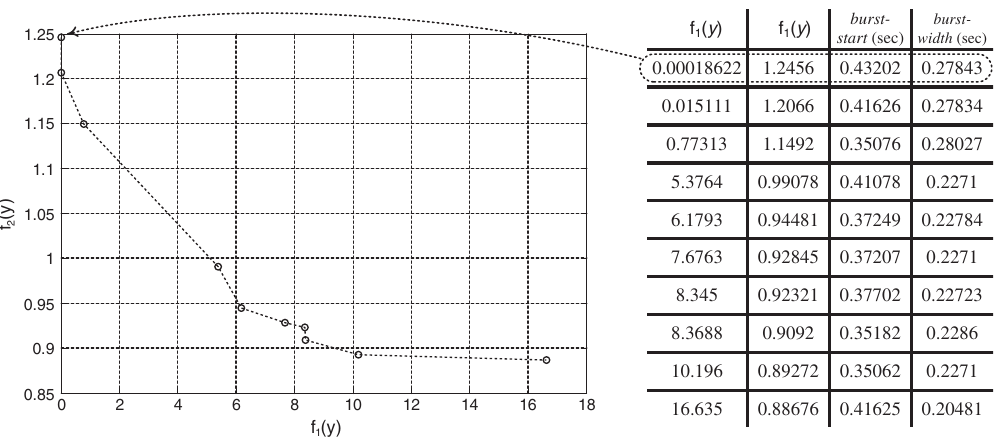
Fig. 10. MOGA optimization/initialization of cycle-to-cycle control: non-dominated solution front (left) and list of optimal parameters